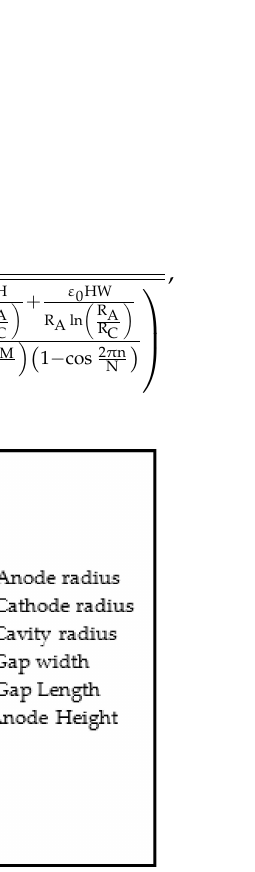
Figure 6. The section areas of the analytical equivalent resonant circuit